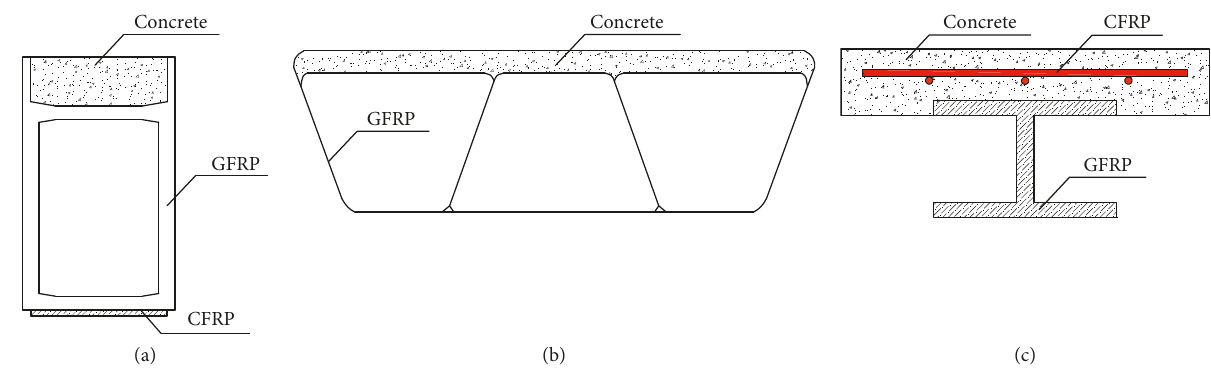
Figure 1: FRP-concrete composite decks with different sections: (a) rectangular section; (b) box section; (c) I-shape section.